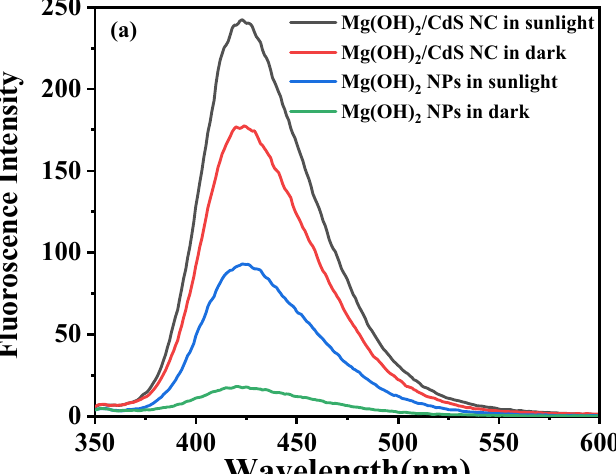
Fig. 7. Determination of hydroxyl radicals during the photocatalytic degradation of β-naphthol under sunlight using photolumines- cence